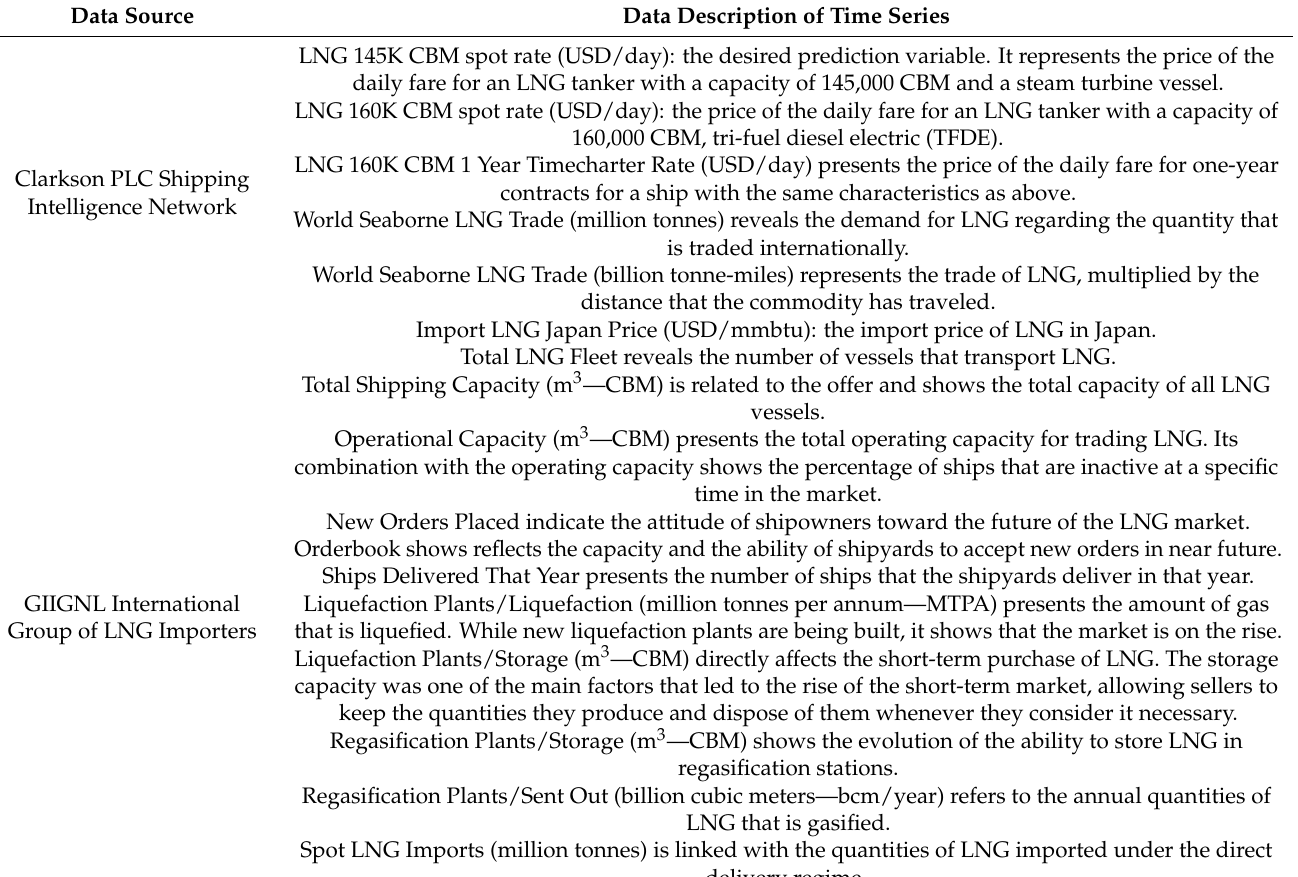
Table 1. Data sources and the time series used in the methodology. Data Source Data Description of Time